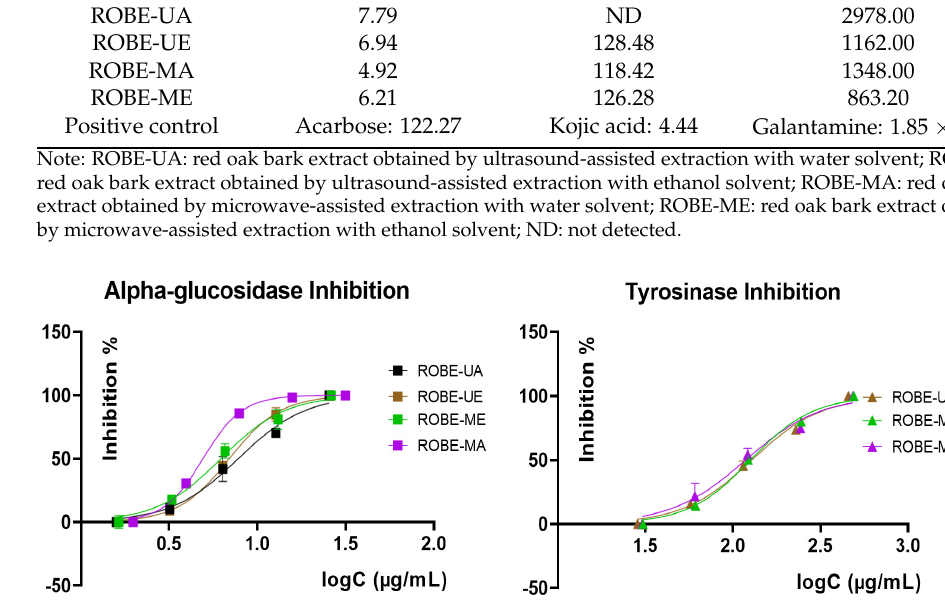
Figure 2. Graphs showing the dependence between the logC (of the concentration in terms of µ g/mL) and the inhibition percentage for the ROBE samples in the case of α -glucosidase and tyrosinase inhibitory activity.